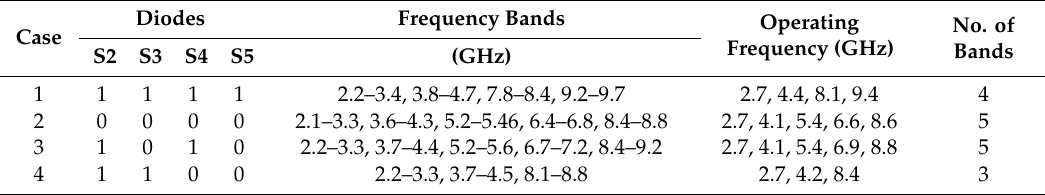
Table 2. Di ff erent configurations of pin diodes and their corresponding operating bands.